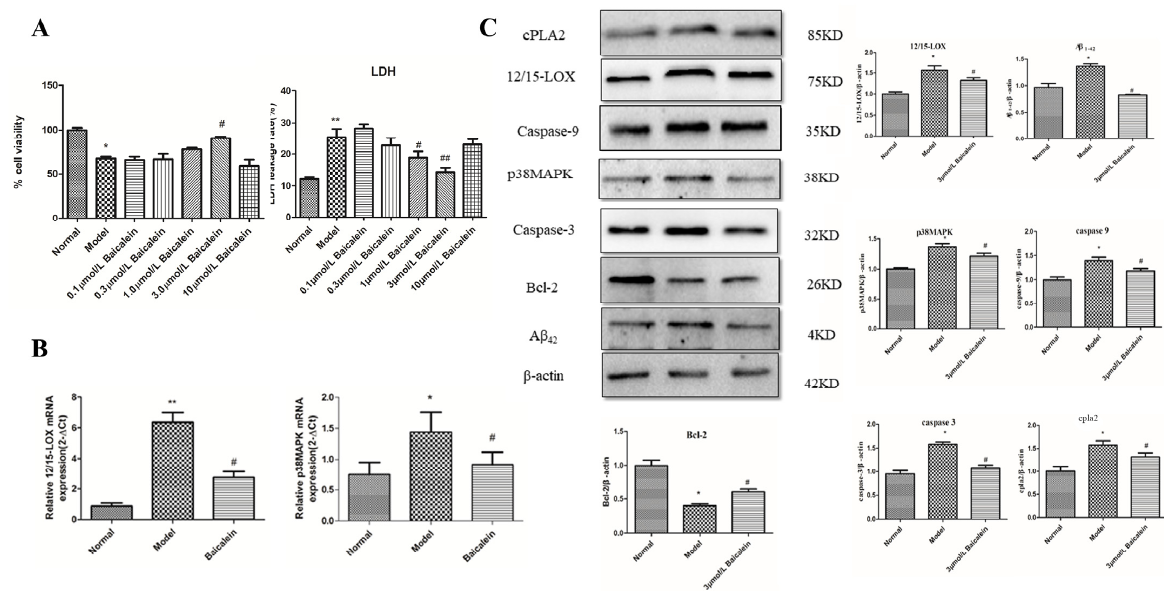
Figure 4. The effect and mechanism of 12/15-LOX in HT22 cells damaged by high glucose. The effect of Baicalein in HT22 cells damaged by high glucose ( A ). Changes in 12/15-LOX and p38MAPK mRNA in HT22 cells damaged by high glucose ( B ). Changes in proteins in HT22 cells damaged by high glucose ( C ). * p < 0.05, ** p < 0.05 compared with normal group; # p < 0.05, ## p < 0.01 compared with model group.